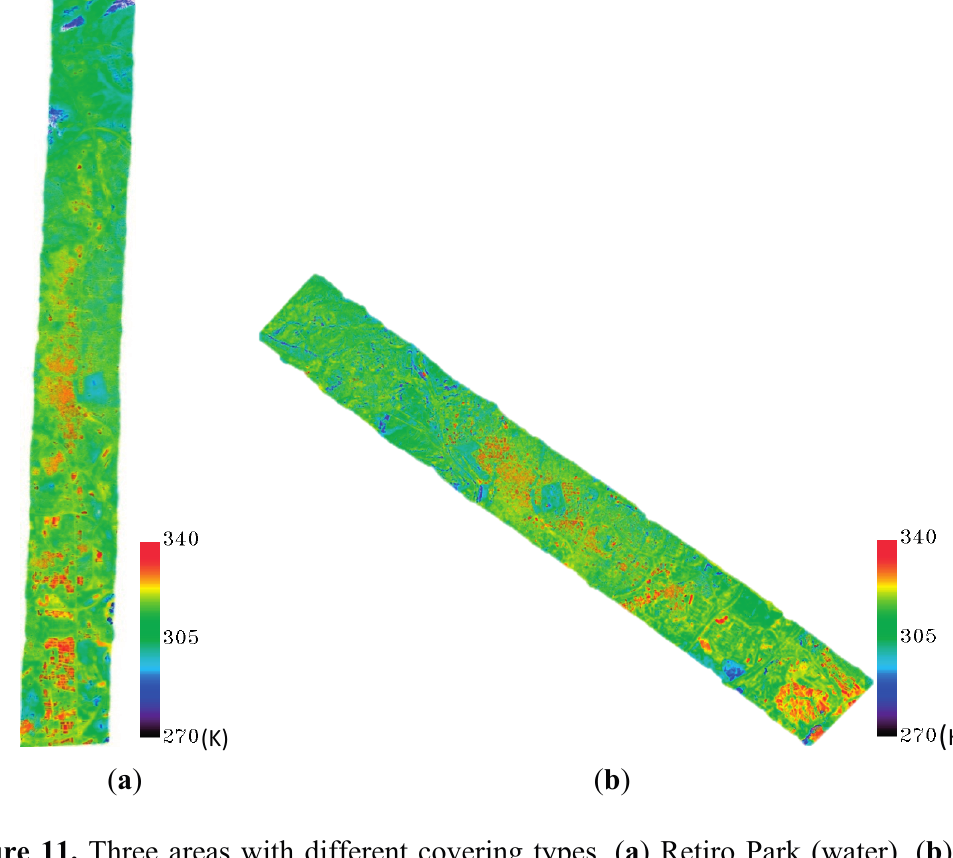
Figure 11. Three areas with different covering types. ( a ) Retiro Park (water). ( b ) Soccer field (bare soil). ( c ) Football field (grass)